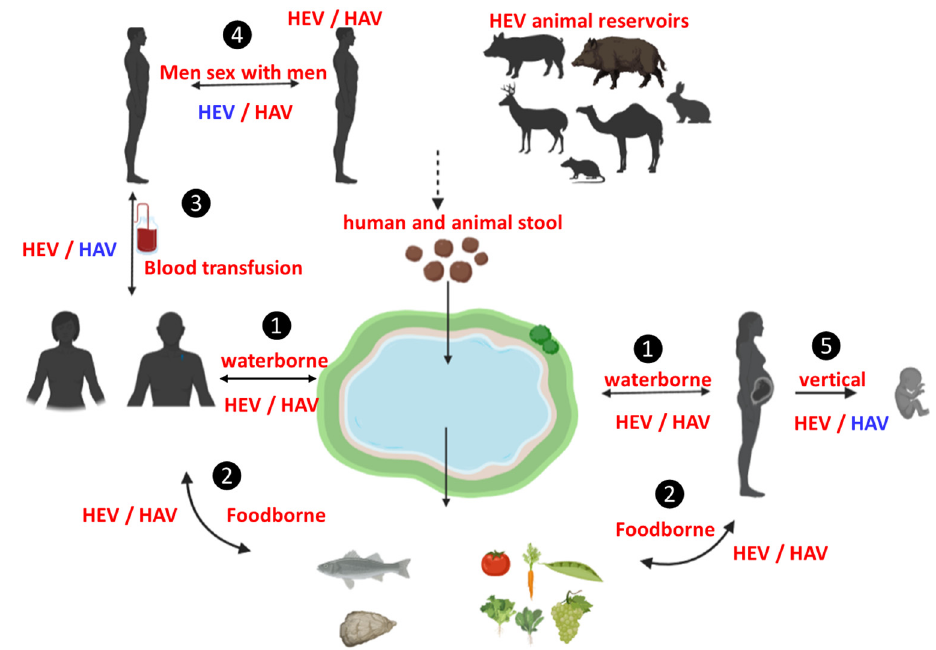
Figure 1. Possible routes of HAV/HEV dual infection. Humans are reservoirs for HAV and HEV, while pigs, wild boar, deer, and other animals are reservoirs for HEV only. (1) Waterborne dual infection has been confirmed for HAV/HEV via the fecal oral route. (2) Foodborne infection—ingestion of vegetables/fruits irrigated by contaminated water or seafood—has been confirmed for both viruses. (3) Blood transfusions, i.e., transmission via transfusion, have been confirmed for HEV (red) but are not a frequent source of HAV (blue). (4) Person-to person-contact such as MSM has been confirmed for HAV (red) but is not a frequent source of HEV (blue). (5) Vertical transmission, i.e., from mother to child, has been confirmed for HEV (red) but is not a frequent source for HAV (blue). For HEV/ HAV: Red means a confirmed source of infection; blue means not a frequent source, which is possible but not confirmed yet.